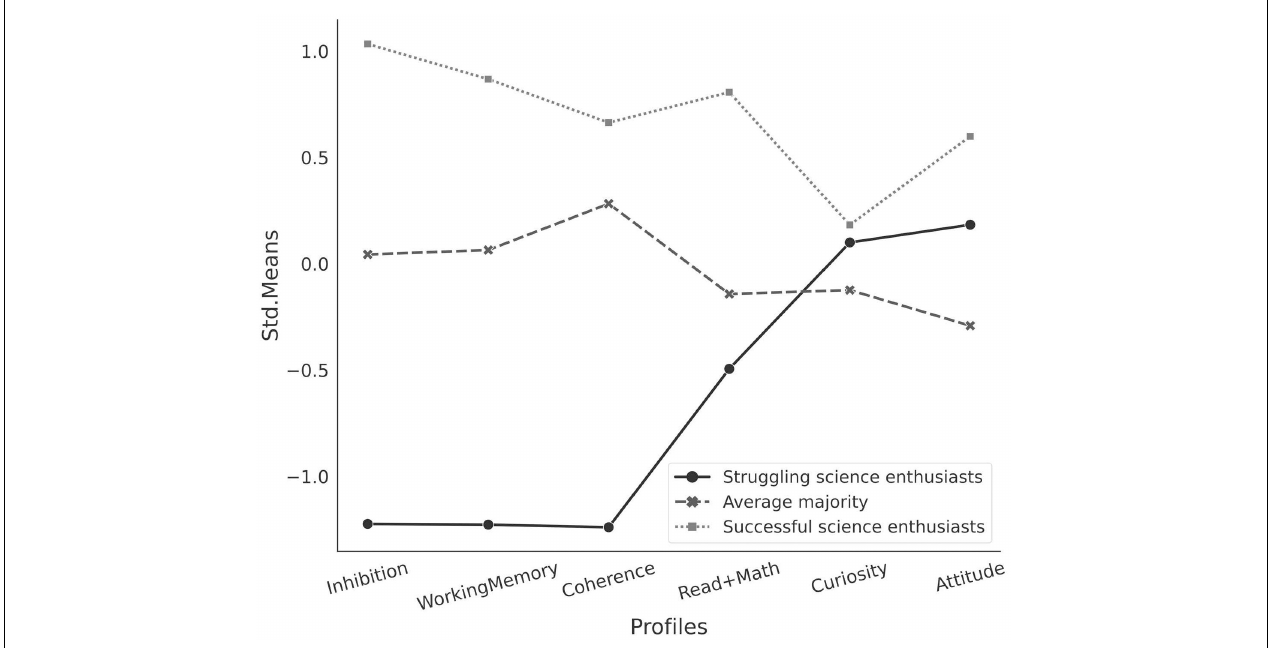
FIGURE 3 | LPA estimates per predictor variable and